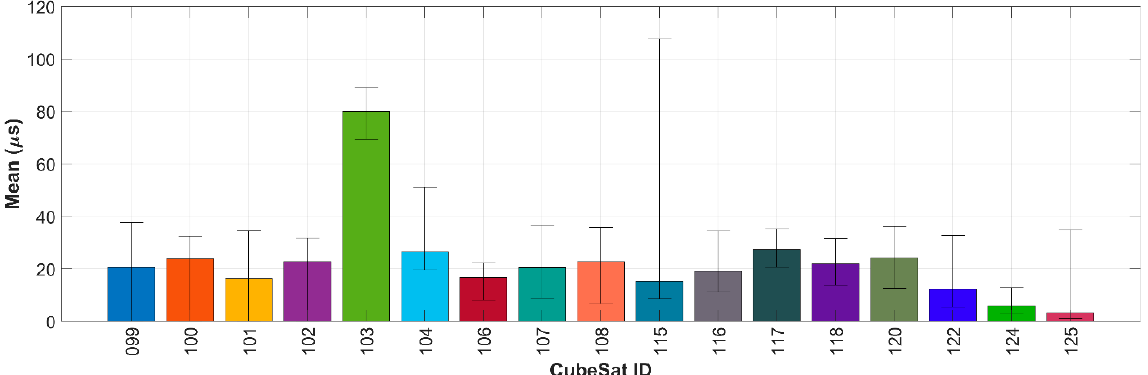
Figure 8. Mean of the improvements in comparing the estimated CubeSats’ clocks before and after applying the proposed corrections in the RD-POD procedure. The lines inside each bar show the minimum and maximum RMS of the improvements over the testing period.